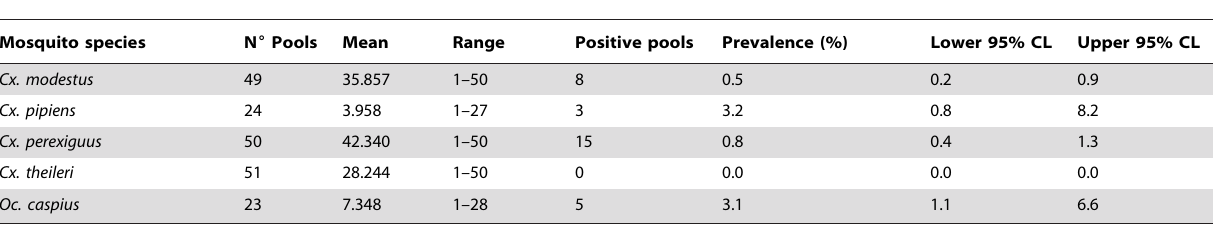
Table 3. Prevalence of avian malaria parasites in unfed